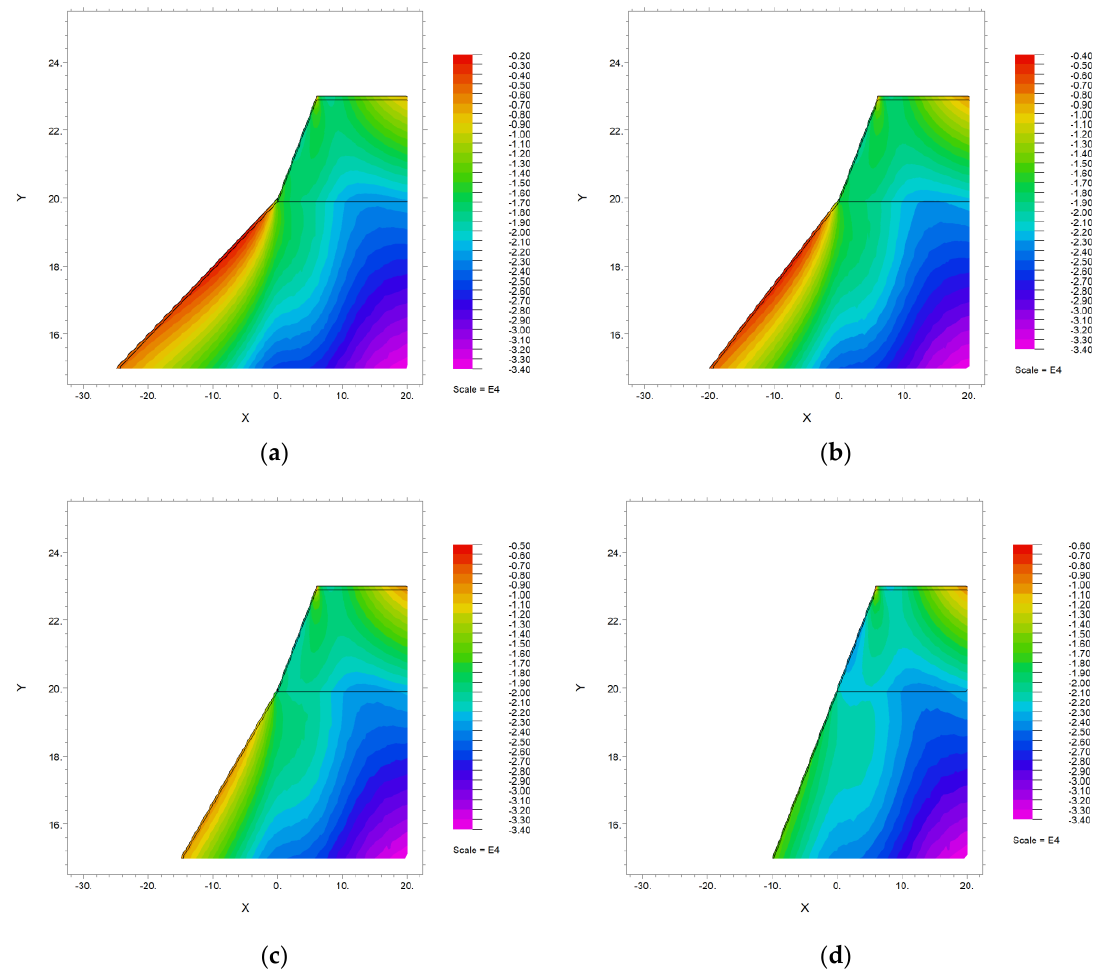
Figure 9. Horizontal stresses for the sand-type subsoil, for underwater slope inclinations of: ( a ) 1:5, ( b ) 1:4, ( c ) 1:3, ( d ) 1:2 (negative values indicate compressive stresses in Pa, and positive values—tensile stresses in Pa).